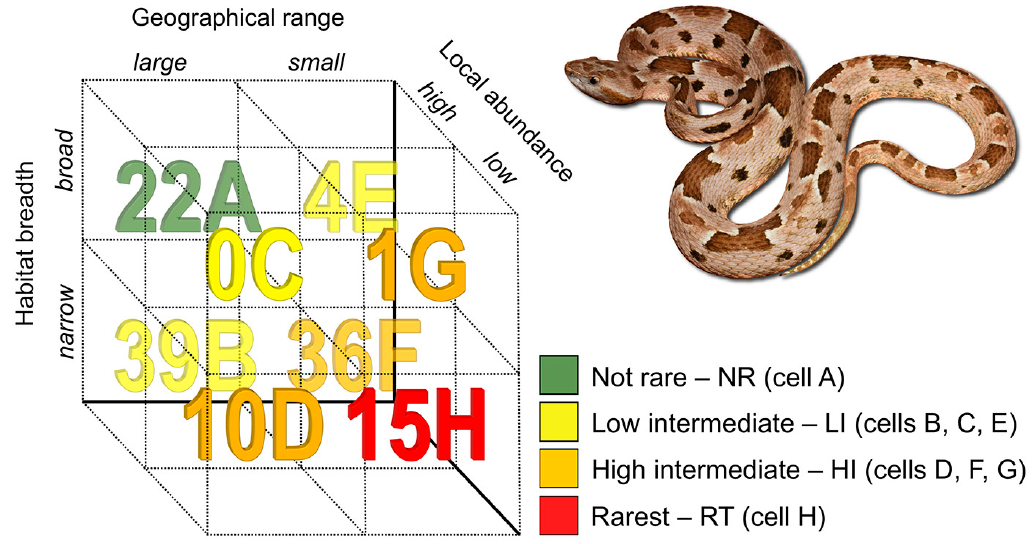
Figure 1. Number of species of New World pitvipers in each rarity cell (letters A to F after each number) of the method proposed by Rabinowitz [10]. The species depicted is Bothrops pauloensis , from southeastern Brazil.